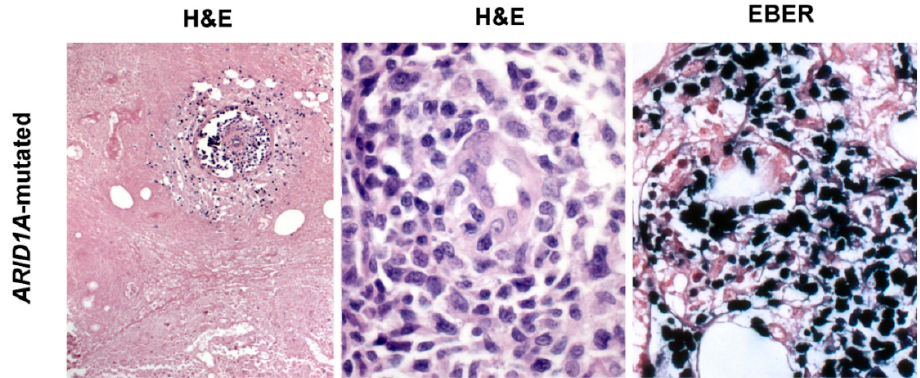
Figure 4. ENKTCL harboring MGA frameshift mutation (c.7586 G > A, p.H533*) associated with MYC overexpression belonging to the MB molecular group. ENKTCL with large cell morphology, cells are pleomorphic with pale cytoplasm, and irregular nuclei (H&E stain, 400×); all lymphoma cells show EBER positivity (in situ hybridization 200×) and MYC nuclear expression (immunohistochemistry 400×). Abbreviations: H&E, hematoxylin and eosin; EBER, in situ hybridization for EBV-encoded small RNA.